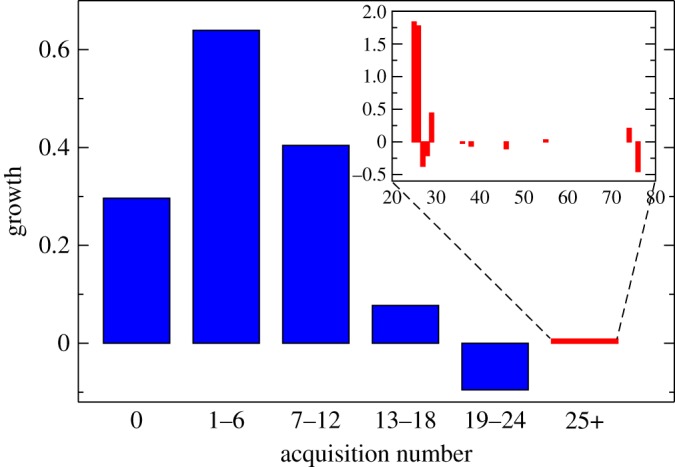
Real business organic growth. The chart shows the actual, organic growth of entities within each acquisition grouping, excluding the effects of GDP growth and balance sheet aggregation from mergers between US banks from 1992 to 2013. For each of the surviving banks in 2013, we aggregated the balance sheets of each of their ancestors in 1992, and indexed by the GDP. As a result, the real organic growth is derived from the ratio between the balance sheets of surviving entities as at 2013, and those of their respective ancestors (GDP linked and aggregated) as at 1992. The scale is relative to GDP such that values >0, =0 and <0 indicate growth greater than, tracking, and less than GDP, respectively. The red bar in the main plot shows the average over those banks with ancestries >25; the inset shows a refined view of growth for these largest banks, by number of acquisitions. Note that in averaging the data shown in the inset to arrive at the >25 bucket shown in the main plot, the average is weighted by balance sheet size.